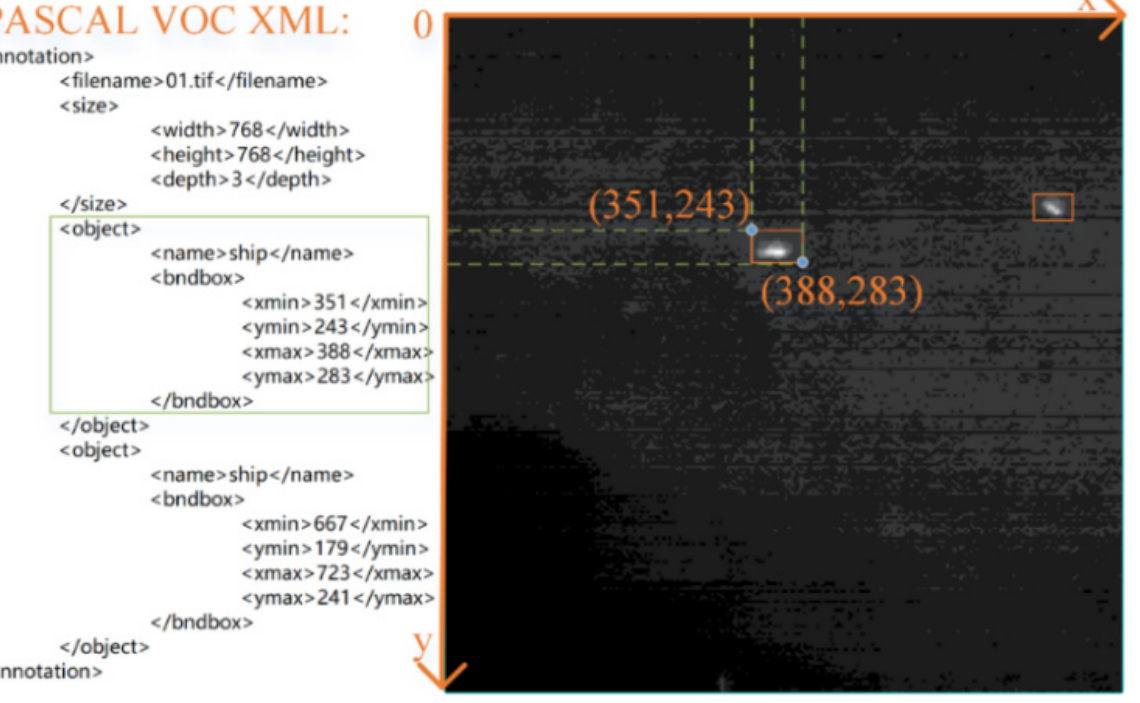
Figure 3. PASCAL VOC XML annotation for 768 × 768 three-bands pseudo-color images with the resolution of 10 m. (351,243) and (388,283) are, respectively, the coordinates of the top left and bottom right of the bounding boxes of the left ships.